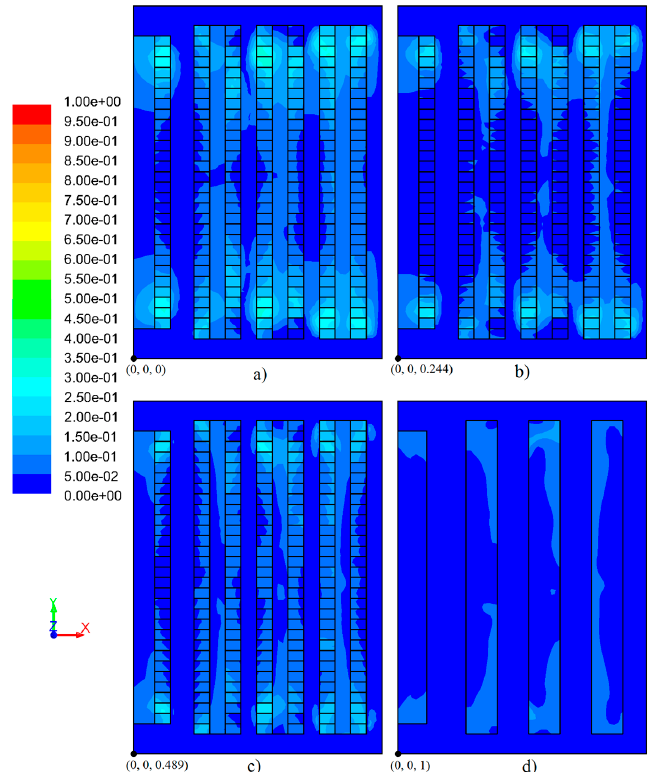
Figure 16. The results of the field of temperature in the x–y plane through the: ( a ) z adm = 0; ( b ) z adm = 0.244; ( c ) z adm = 0.489; and ( d ) z adm = 1.